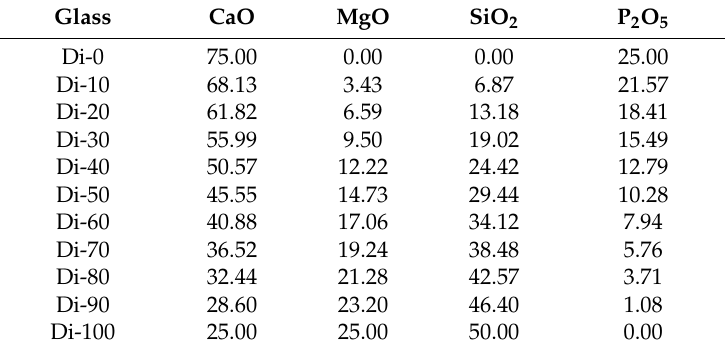
Table 13. Batch compositions of the glasses (mol